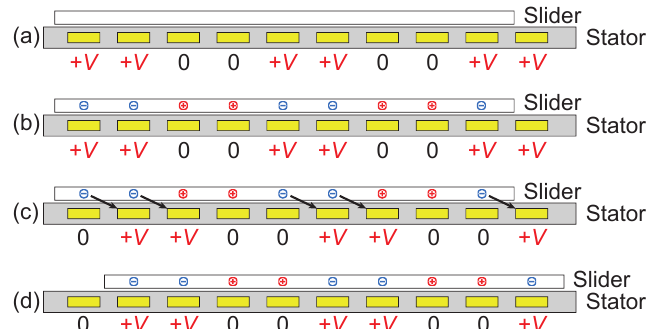
Figure 2. Driving principle of charge-induction electrostatic actuators using a mono-polar high voltage. The voltage, V , is typically around 1 kV. ( a ) Voltages are applied to the stator electrodes; ( b ) charges are induced on the slider surface; ( c ) voltages on the stator electrode are shifted; ( d ) the slider moves about one electrode pitch.